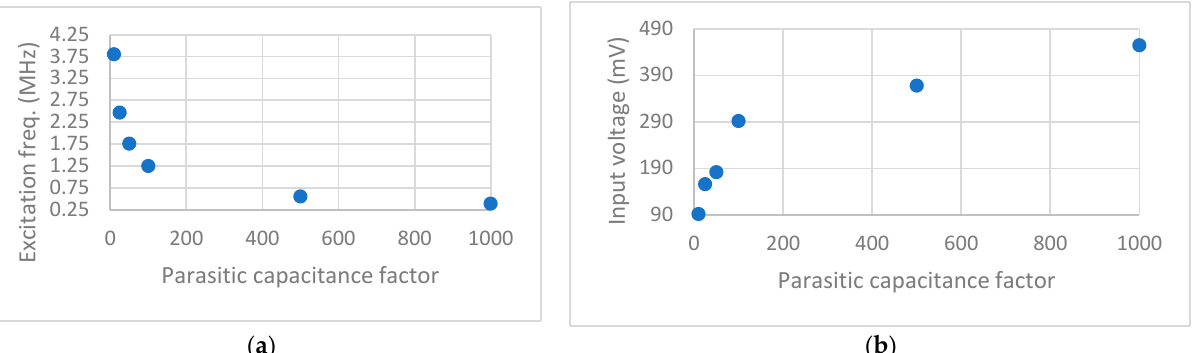
Figure 10. Changes in system parameters due to increased parasitic capacitance (parasitic capacitance factor), ( a ) decreased excitation frequency, and ( b ) increased input voltage.